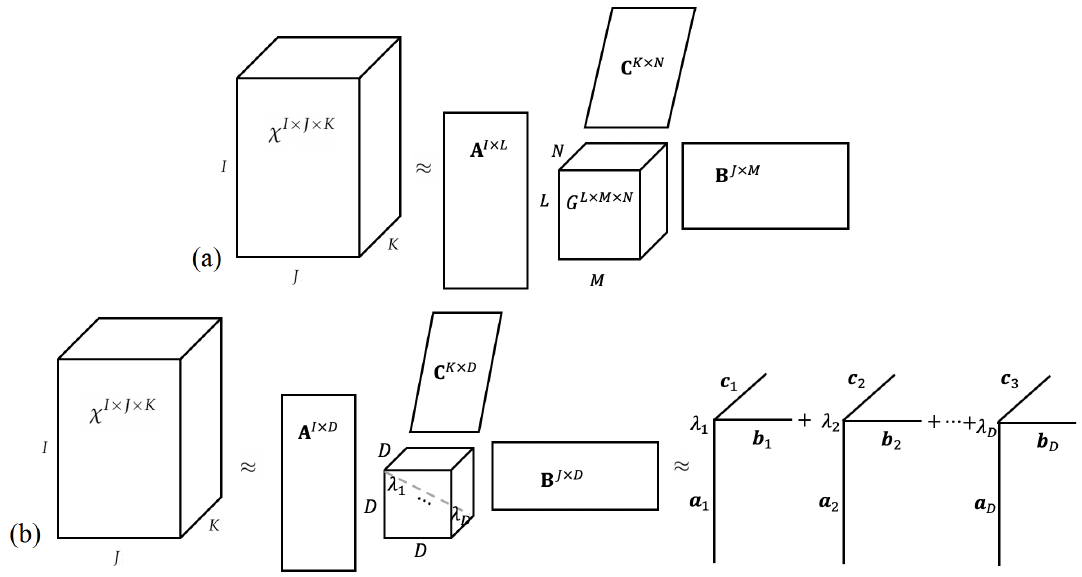
Figure 6. ( a ) Tucker model Tc( L , M , N ); ( b ) CANDECOMP/PARAFAC model CP( D )